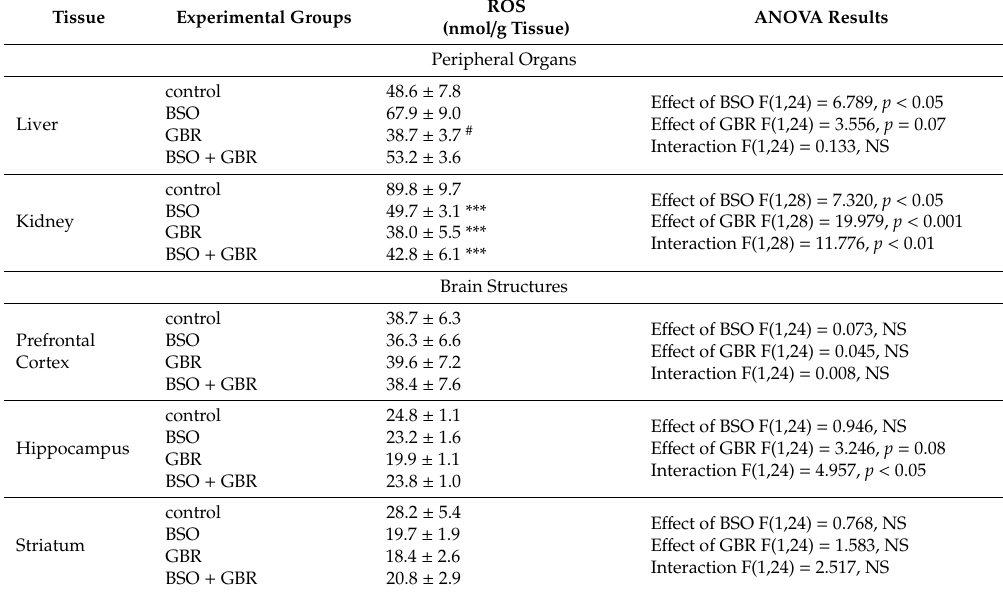
Table 1. The e ff ects of chronic treatment with l-Buthionine-(S,R)-sulfoximine (BSO) and / or 1-[2-[Bis(4-fluorophenyl)methoxy]ethyl]-4-(3-phenylpropyl)piperazine dihydrochloride (GBR 12909), alone and in combination, on the total reactive oxygen species (ROS) levels in the peripheral organs and the selected brain structures of 16-day-old Sprague-Dawley